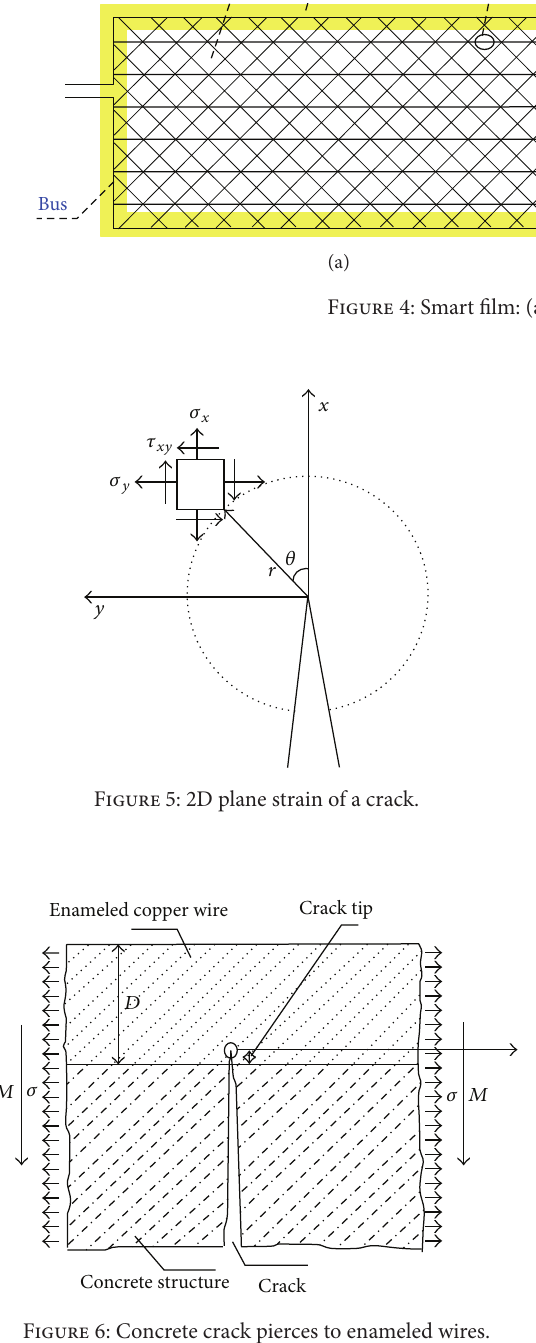
Figure 6: Concrete crack pierces to enameled wires.